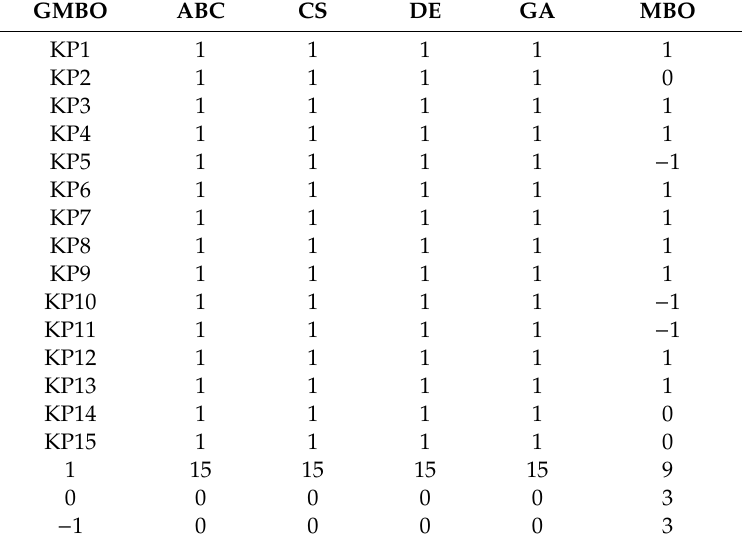
Table 11. Rank sum tests for GMBO with the other five methods on